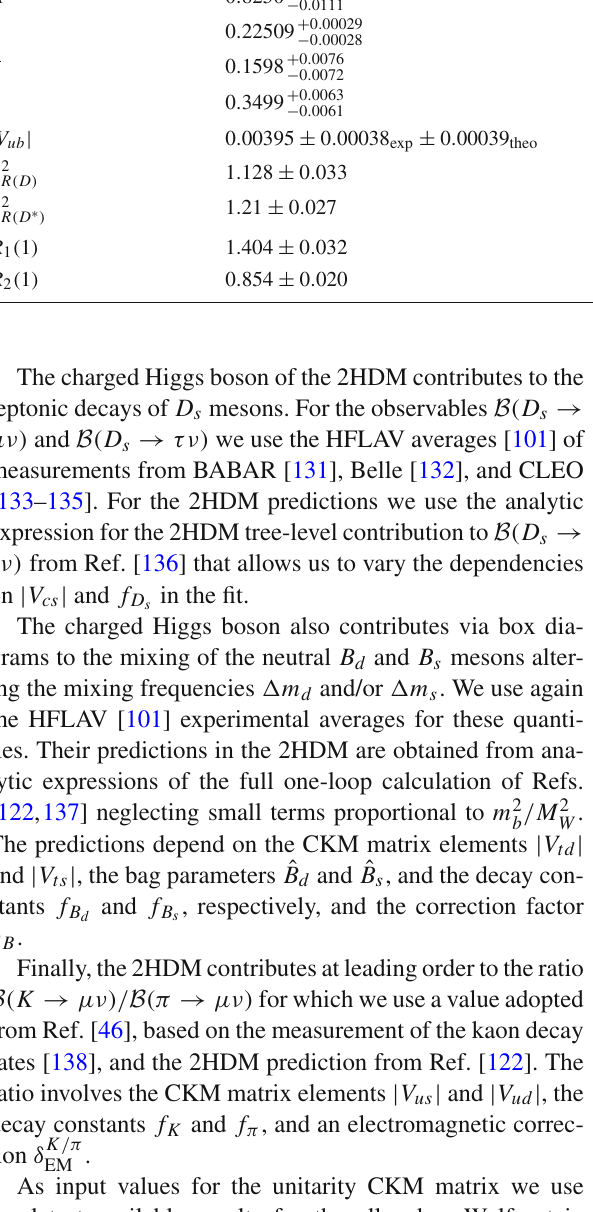
are calculated from the Wolfenstein parameters. The parameters related , ρ 2 , R 1 ( 1 ) , R 2 ( 1 ) are taken to the R ( D ( ∗ ) ) measurements, ρ 2 R ( D ) R ( D ∗ ) /π from Ref. [101]. Value and uncertainty for δ K are taken from EM